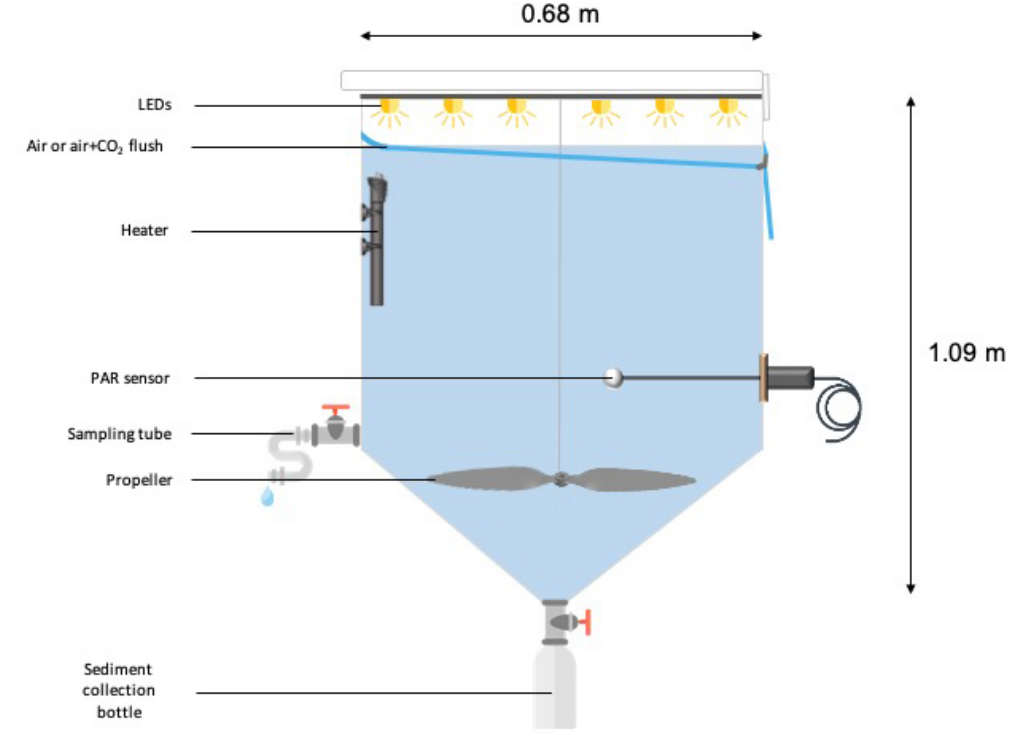
Figure 2. Diagram of an experimental tank (climate